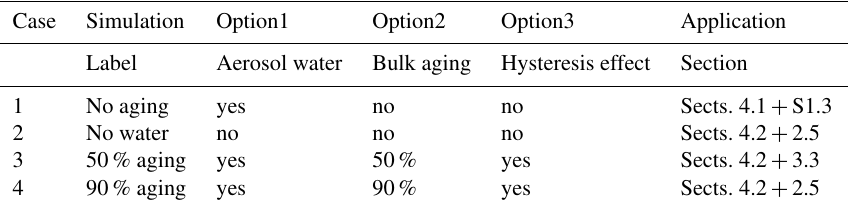
Table 4. Sensitivity runs with different levels of chemical aging of bulk species as defined in Sect. 4.2 and Table 2. Note that the key difference between no aging and aging is the water uptake of primary particles. This is only considered for the latter case (being based on Sect. 2.4 and 2.5). All cases include the GMXe coating processes (Sect. 2.2) through condensation of gases such as hydrochloric acid, nitric acid, sulfuric acid, and ammonia on insoluble particles (mineral DU, black, and organic carbon). Additionally, in all cases particles can mix through coagulation, and the formation of semi-volatile salt compounds such as ammonium nitrate and ammonium chloride. Also, the associated gas–aerosol partitioning and water uptake (Sect. 2.3) are always applied for compounds in the soluble